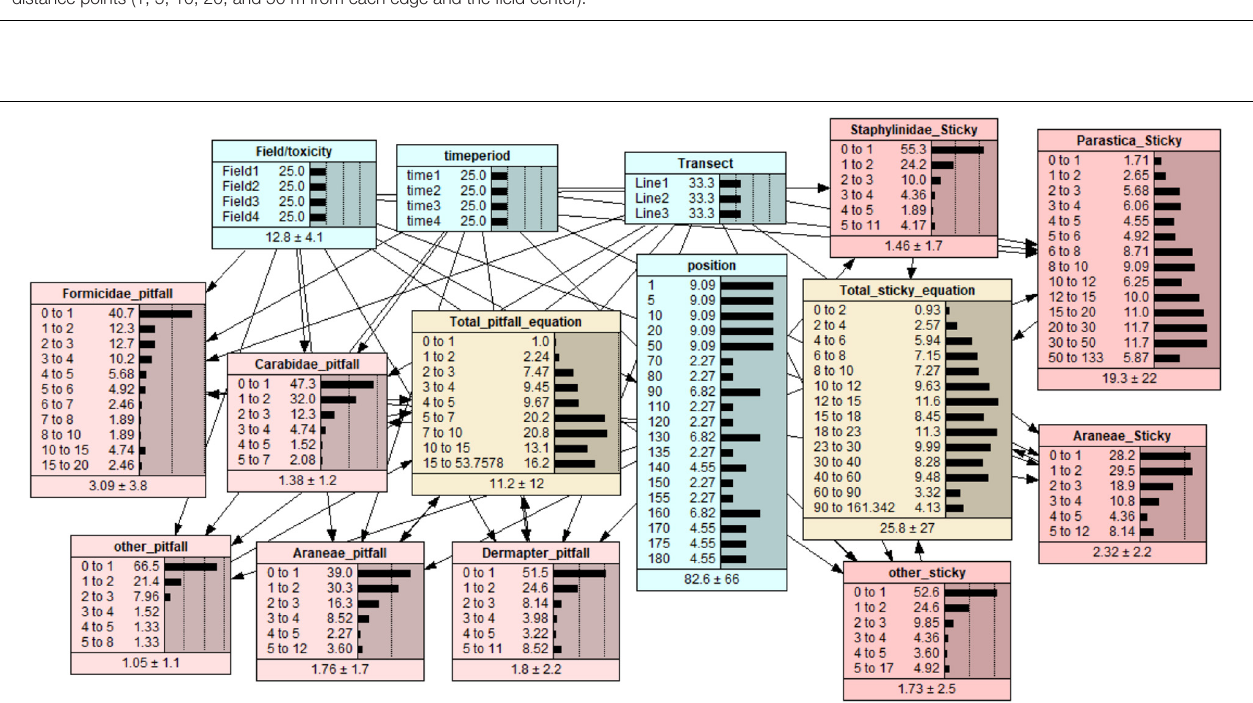
FIGURE 2 | Schematic diagram of each field of study: The perennial native vegetation is considered as a “treatment” for attracting natural enemy insects for the benefit of growing brassica crops and farm road considered as control. The dotted line in the brassica field are transects were data collection was done in 11 distance points (1, 5, 10, 20, and 50 m from each edge and the field center).